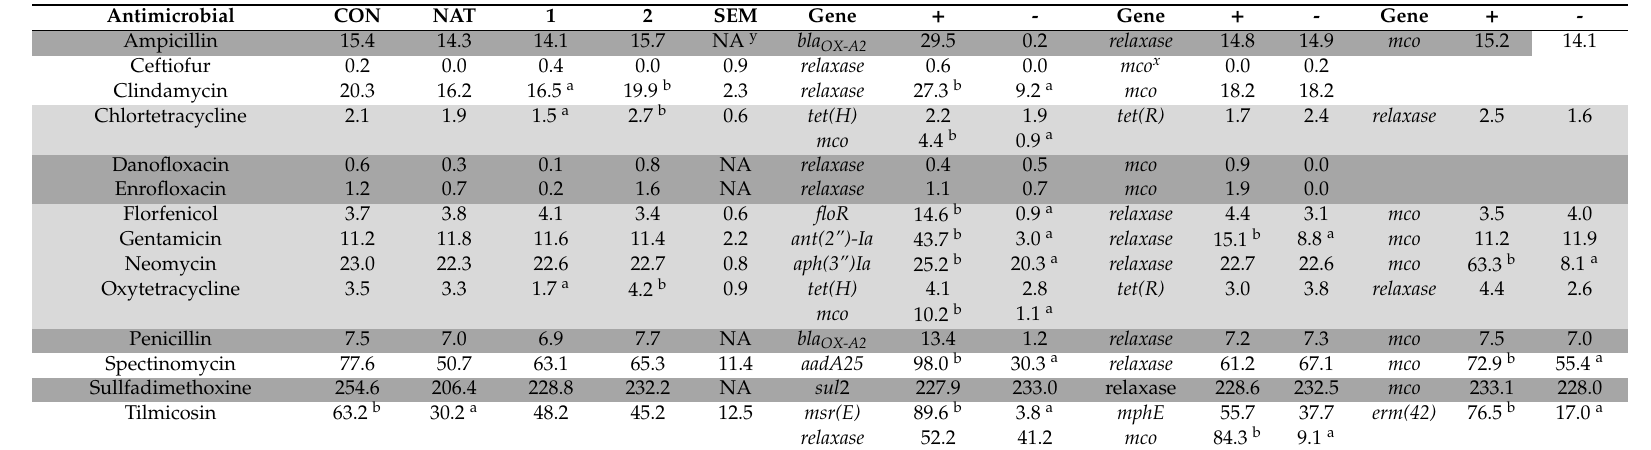
Table 5. E ff ect of management z , year of study and presence of ICE core and antimicrobial resistance genes of minimum inhibitory concentrations (MICs) for M. haemolytica ( n = 104). Least square means are reported for antimicrobials showing unimodal (unshaded) or selected bimodal distributions (shaded in light grey). Arithmetic means are reported for other distributions (shaded in dark grey). MICs < or > than the range of concentrations evaluated were estimated as the next lower or higher concentration commonly used on the Sensititre